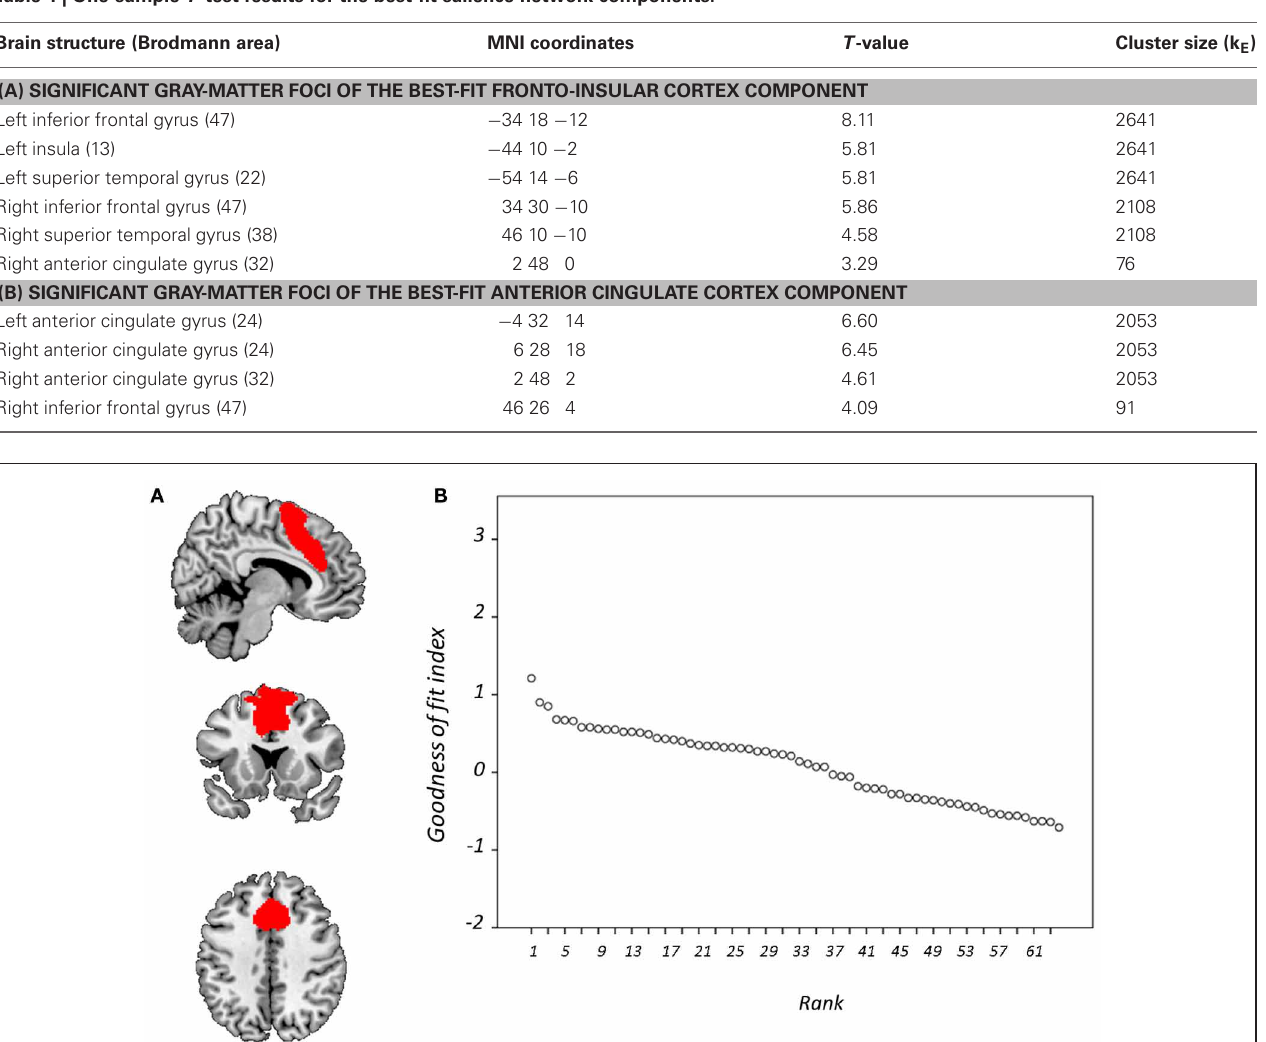
FIGURE 6 | Goodness-of-fit (GOF) with anterior cingulate cortex mask. Showing (A) the mask is overlaid onto a standardized T 1 -weighted image shown according to the neurological convention; and (B) GOF with this mask for each component displayed according to